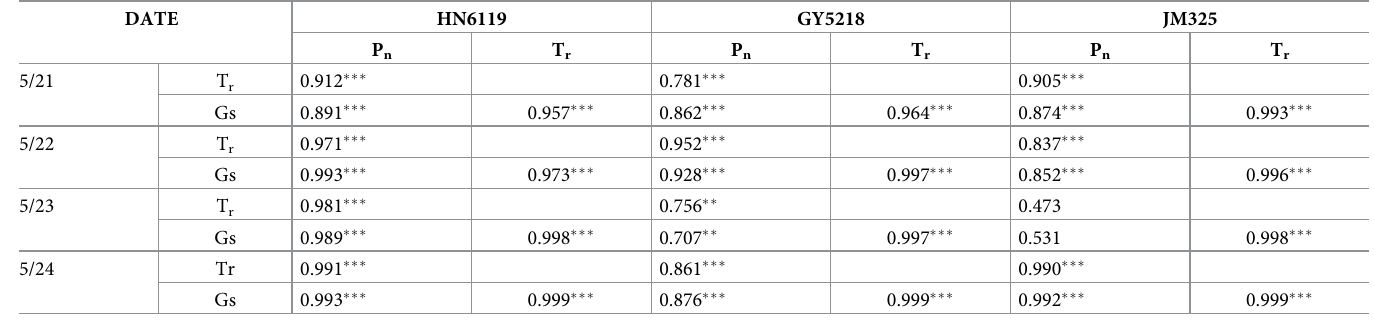
Table 5. Correlation coefficient of different photosynthetic physiological parameters for the three cultivars from May 21 st to 24 th during the 2019